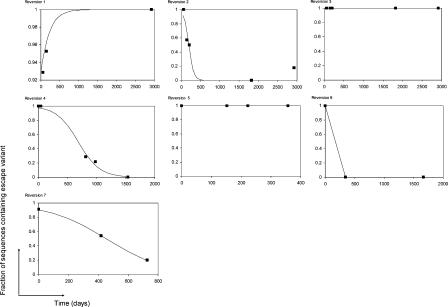
Reversion Data and Theoretical FitsFit of the model (solid line) to the experimental data (filled square) for each of the seven reversion datasets.